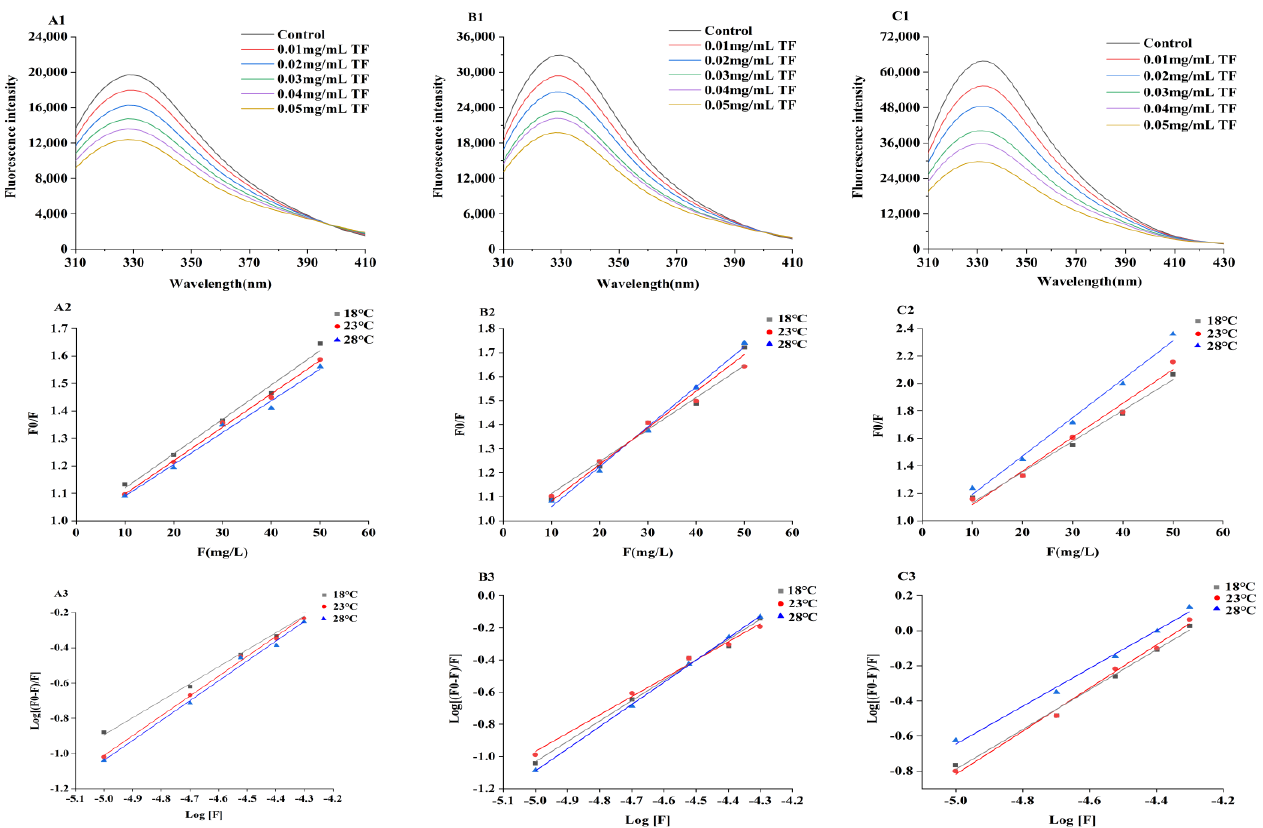
Figure 5. Fluorescence analysis of the interaction of proteins with flavonoids. ( A1 – C1 ): The fluo-